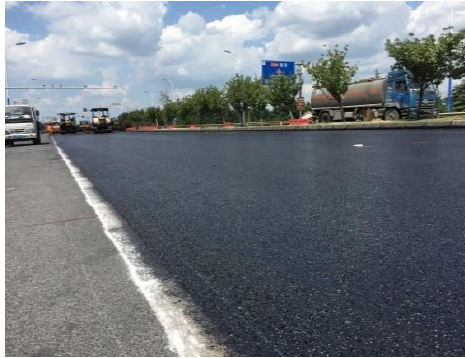
Figure 12. Scene after construction of tack coat.